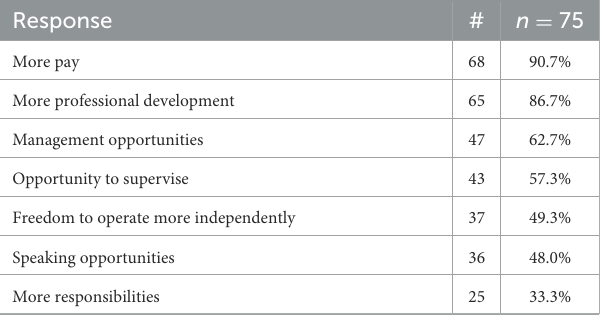
TABLE 5 Most frequently appearing codes for responses to open-ended question, “What factors need to be considered to move CHWs from one level to the